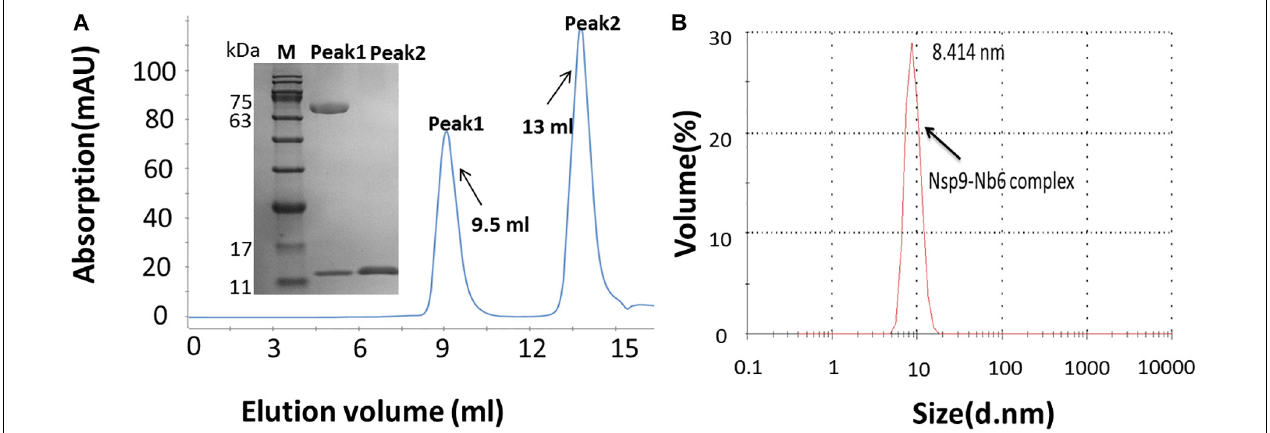
FIGURE 2 | The Nsp9-Nb6 complex exists as a heterodimer. (A) The Nsp9-Nb6 complex was purified with high purity by calibrated Superdex 75 10/300 GL column. Two peaks were observed, with the retention volume of the Peak1 was 9.5 ml, corresponding to the heterodimer of the Nsp9-Nb6 complex, and the retention volume of the Peak 2 was about 13 ml, corresponding to the monomer of Nb6. Characterization of the complex after purification was analyzed by SDS–PAGE (Inset) M: protein ladder (10–180 kDa, Sorlarbio, Beijing, China), Gel: 12% precast polyacrylamide gel (Item No. NP0341BOX, Thermo Fisher Scientific). (B) DLS of Nsp9-Nb6 complex at 1.5 µ M. The hydrodynamic molecular radius of the complex is 8.414 nm.